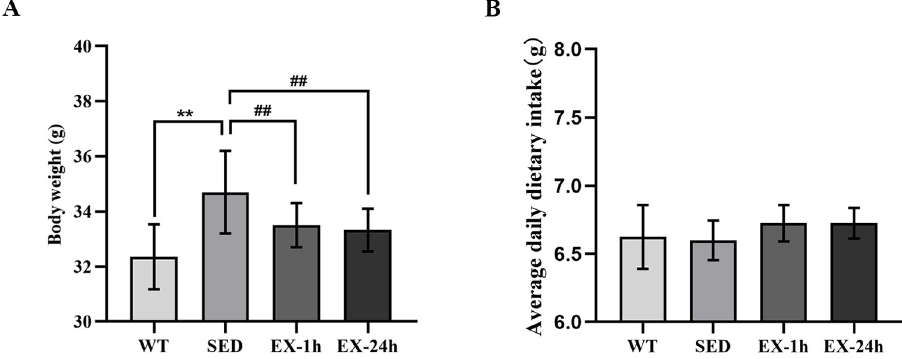
Fig 1. Aerobic exercise reduces body weight without changing dietary intake. ( A ) Body weight at the end of the experiment. ( B ) Average daily dietary intake. Data are presented as mean ± SD (n = 20). �� p < 0.01 vs. WT group; ## p < 0.01 vs. SED